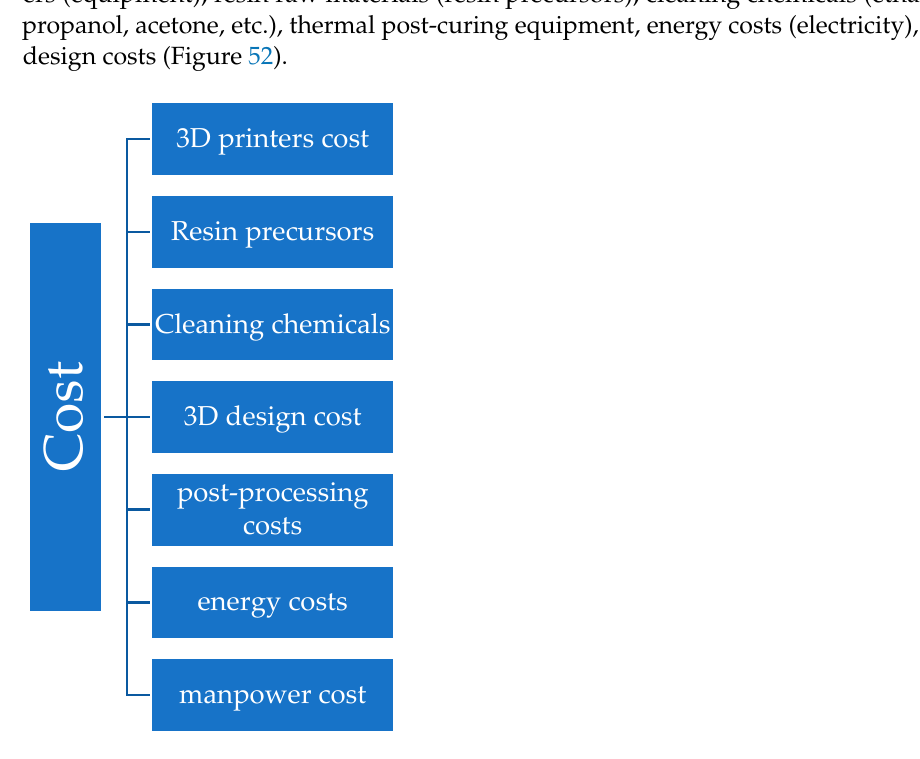
Figure 52. Investment and running costs in vat photopolymerization 3D printing technology.